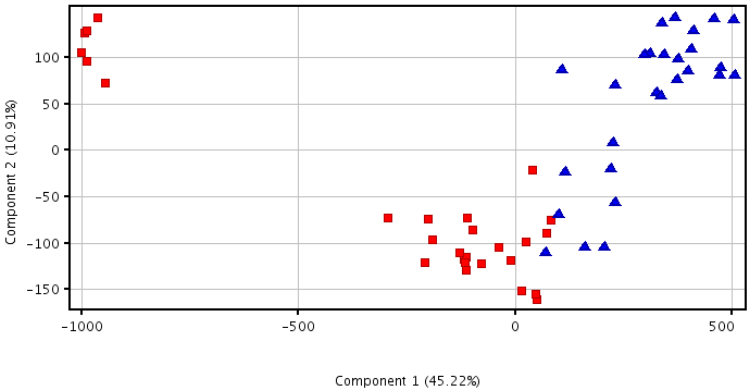
Figure 2. PCA three-dimensional scores plot of plasma metabolic profiling for the top three components which distinguish ESCC patients (blue triangle) from healthy controls (red square).